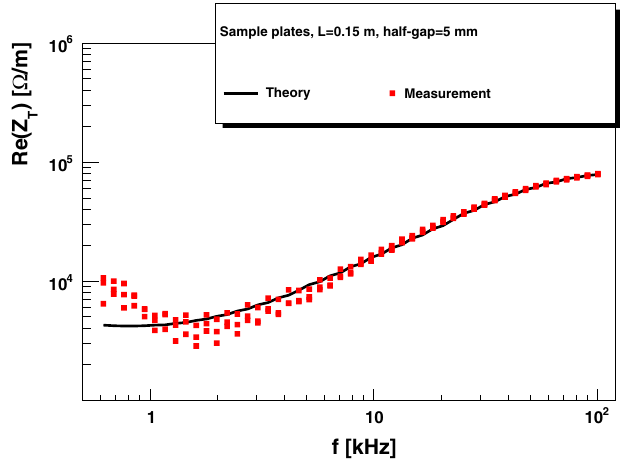
FIG. 14. (Color) Real part of the transverse impedance of graph- ite plates (stage 1 in Table Fig. 14. This confirms the almost perfect agreement with theory for frequencies above 3 kHz.